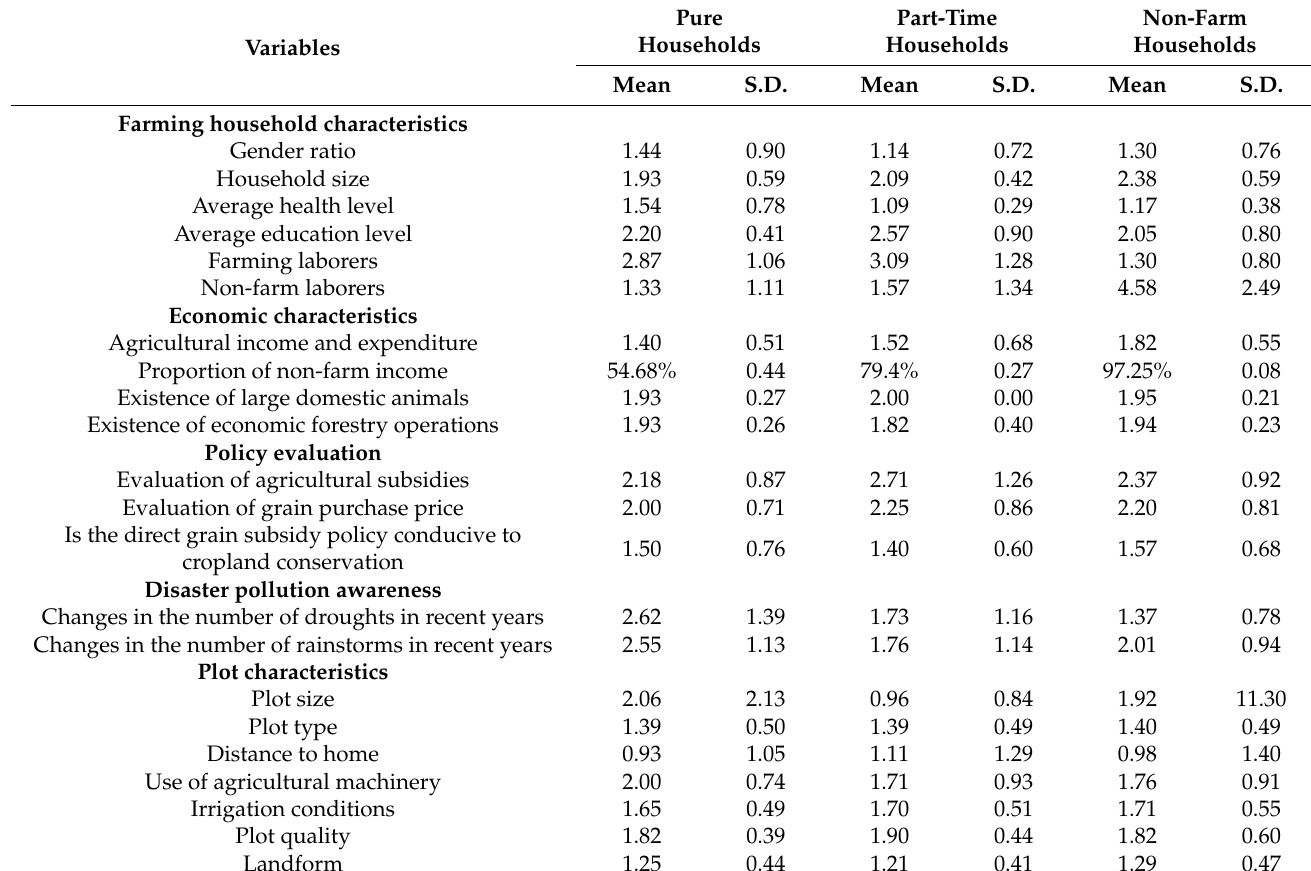
Table 3. Sujiadang Township (hilly topographic region).